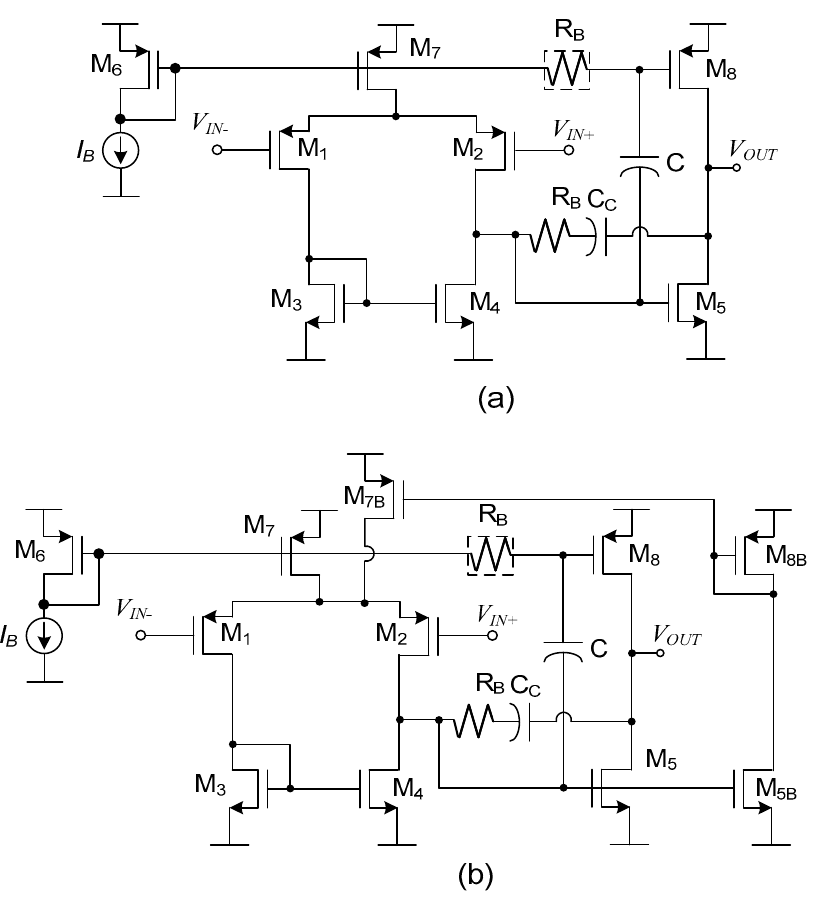
Figure 7. Two-stage Miller amplifiers. ( a ) Class A/AB. ( b ) Class AB/AB.